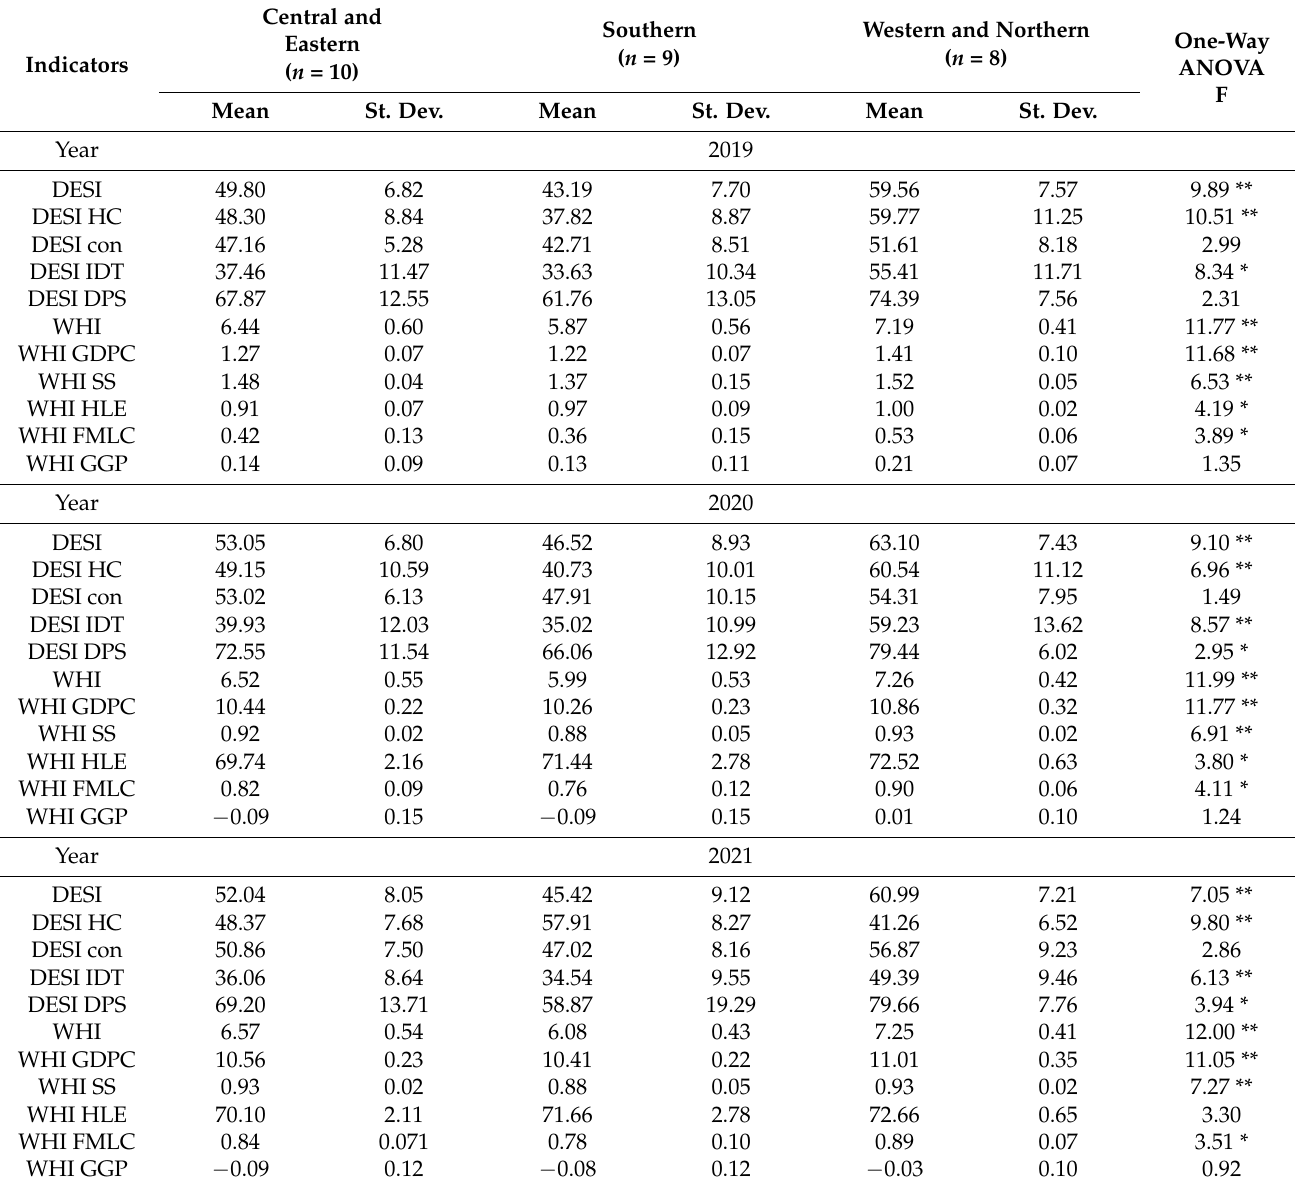
Table 6. Group tests on EU regions (one-way